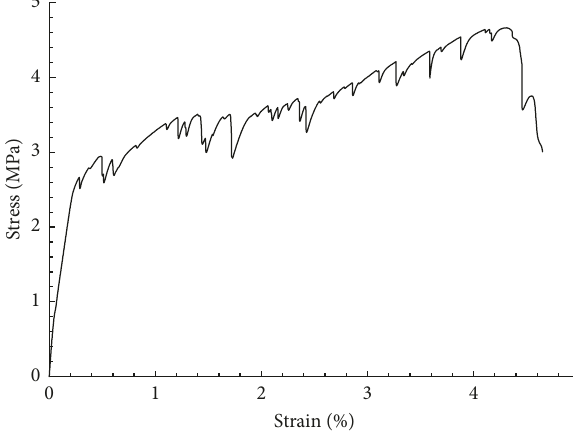
Figure 3: Uniaxial tensile stress-strain curve of ECC.